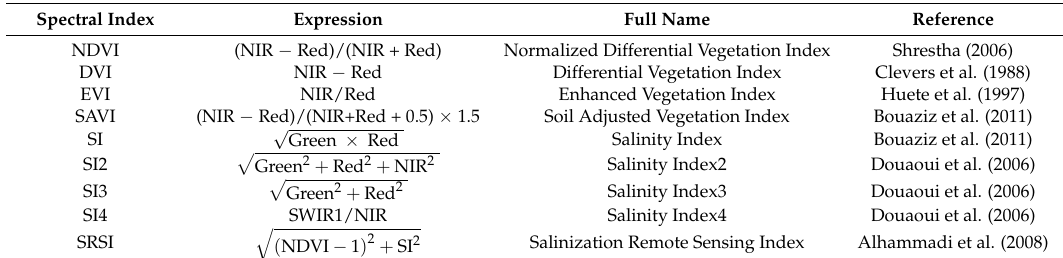
Table 1. The expressions of spectral